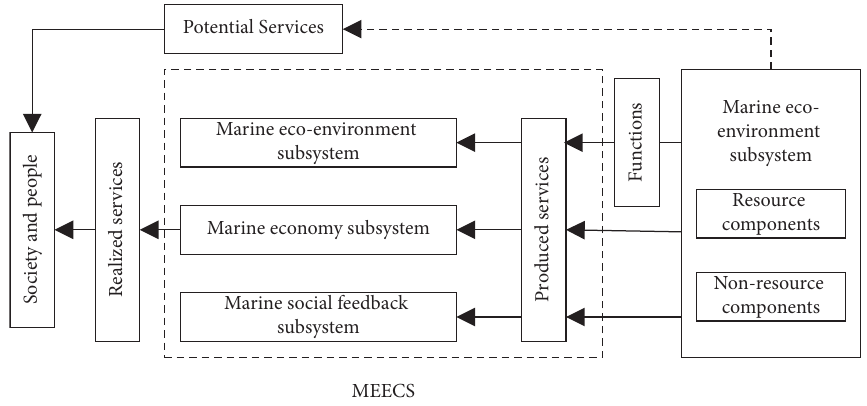
Figure 3: Connotations of the complex system.